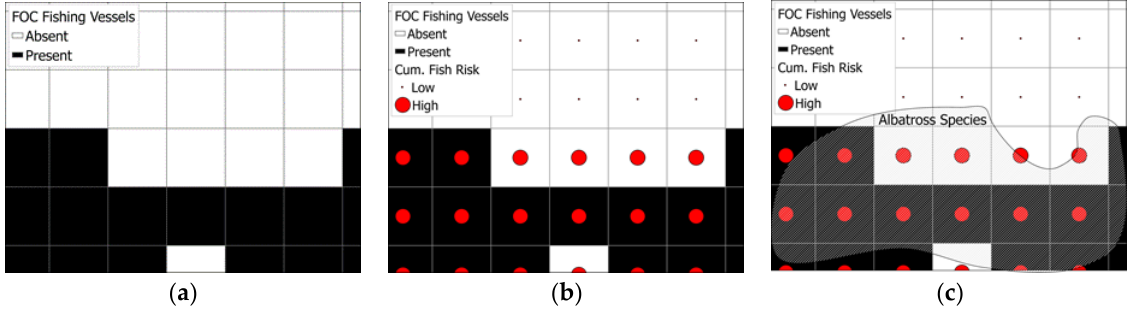
Figure 1. Conceptualizing the relationship among illegal longline fishing, albatrosses, and commer- cially viable fish. In ( a ), the presence of FOC longliners is visible in the black-colored grid cells. FOC longliners tend to be in areas where there is a greater risk score of commercially viable fish, as noted by the larger graduated symbols in ( b ). In ( c ), the theoretical relationship among all three variables is visible. FOC longliners are present in areas with higher risk scores of commercially viable fish and these same areas tend to overlap with distributions of albatross